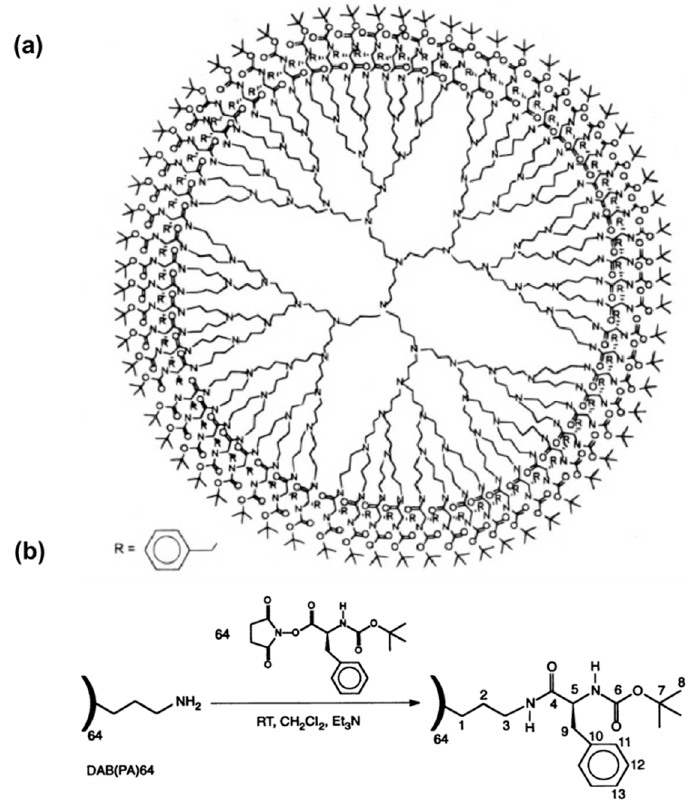
Figure 13. ( a ) Structure of a DAB core, (G4), boc-protected, α -aminoacid-terminated PPI dendrimer referred to as a dendritic box and ( b ) synthesis of the shell defining the dendritic box. Reprinted with permission from [57]. Copyright 1995 American Chemical Society.